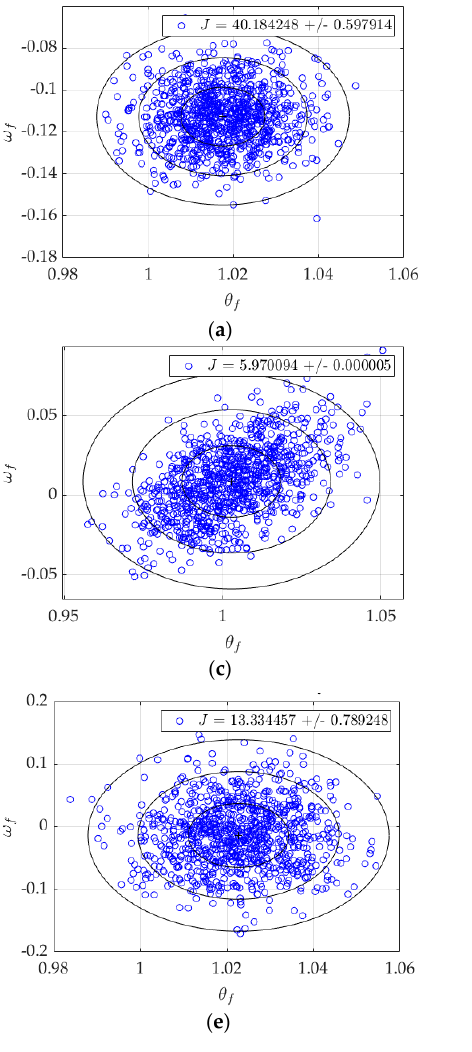
Figure 4. Monte Carlo plots, N = 1000. Rings show 1-sigma, 2-sigma, and 3-sigma deviations from the mean, denoted by a +. ( a ) P+V control; ( b ) open-loop optimal control; ( c ) RTOC; ( d ) double-integrator patching fi lter; ( e ) double integrator, tuned; ( f ) control law inversion patching fi lter. Table 1. Numerical results of Monte Carlo simulations, N = 1000. 𝜎 refers to the standard deviation of a quantity. All other numerical results represent the mean over all simulations.